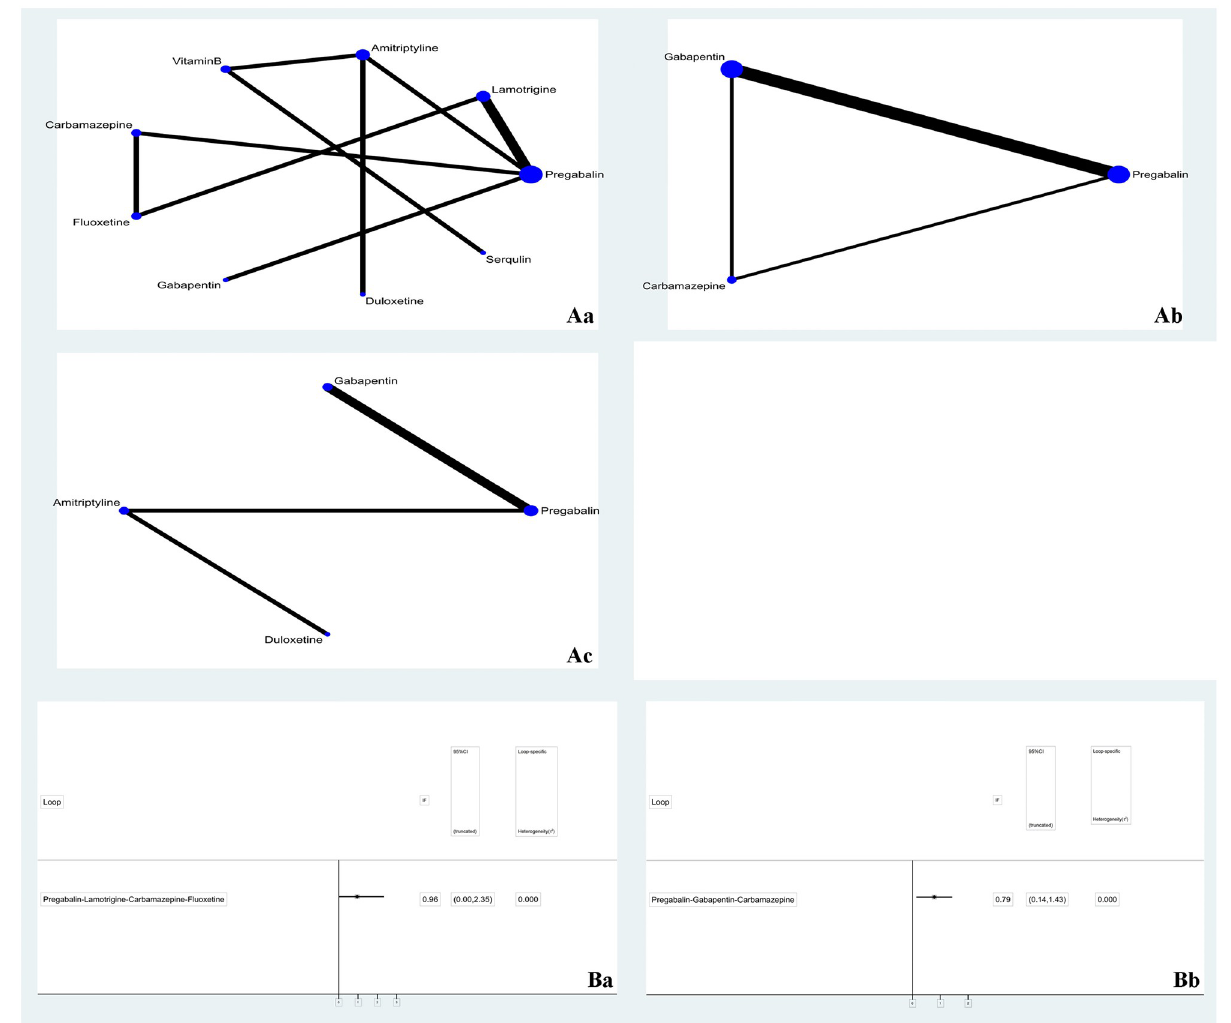
Fig 3. A . Network diagram (Aa: VAS; Ab: NRS; Ac: HAMD); B . inconsistency (Ba: VAS; Bb: NRS).